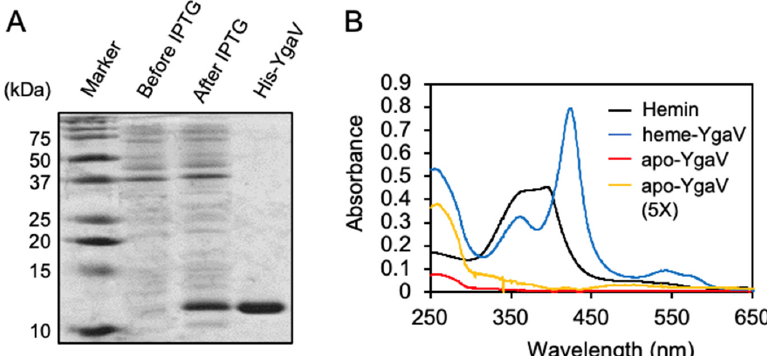
Figure 2. Purification and reconstitution of YgaV: ( A ) SDS-PAGE analysis of purified His-tagged YgaV. Cell extracts of E. coli expressing N-terminally His-tagged YgaV, before and after IPTG induction, are also analyzed. Proteins were stained with Coomassie brilliant blue; ( B ) Absorption spectra of hemin, heme-reconstituted YgaV (heme-YgaV), purified YgaV before reconstitution (apo-YgaV), and 5-times concentrated purified YgaV before reconstitution (apo-YgaV, 5 × ). Next, we checked the DNA ‐ binding property of YgaV to the ygaVP promoter. For